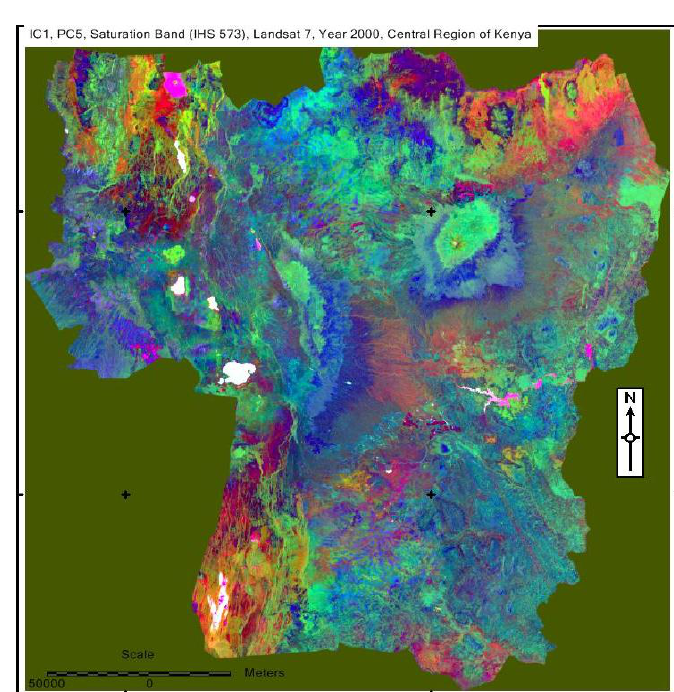
Figure 3: FCC {IC1,PC5, Saturation Band (573)} Landsat 7